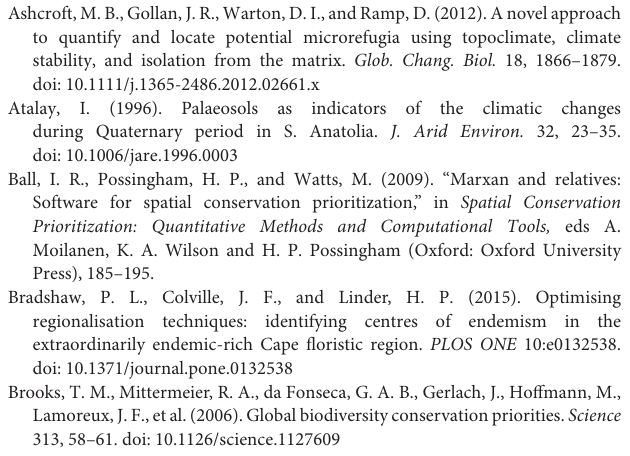
(Michaux et al., 2004; Magyari et al., 2008). Therefore, lowlands and lower montane zones are considered suitable habitats for temperate species to survive the last glacial maximum (Rokas et al., 2003; Dubey et al., 2006, 2007; Fritz et al., 2009; Ahmadzadeh et al.,